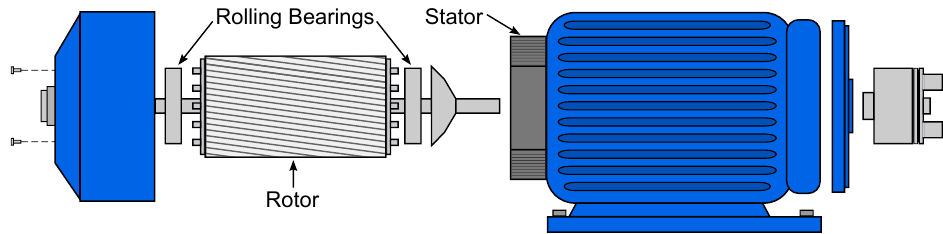
Figure 1. Three fundamental components of an induction motor: stator, rotor, and rolling